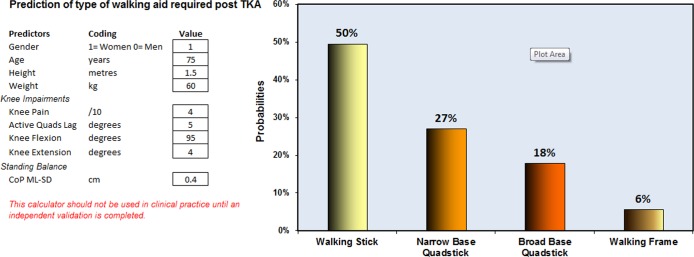
Screenshot of the spreadsheet with calculations of predicted probabilities for each type of walking aid.